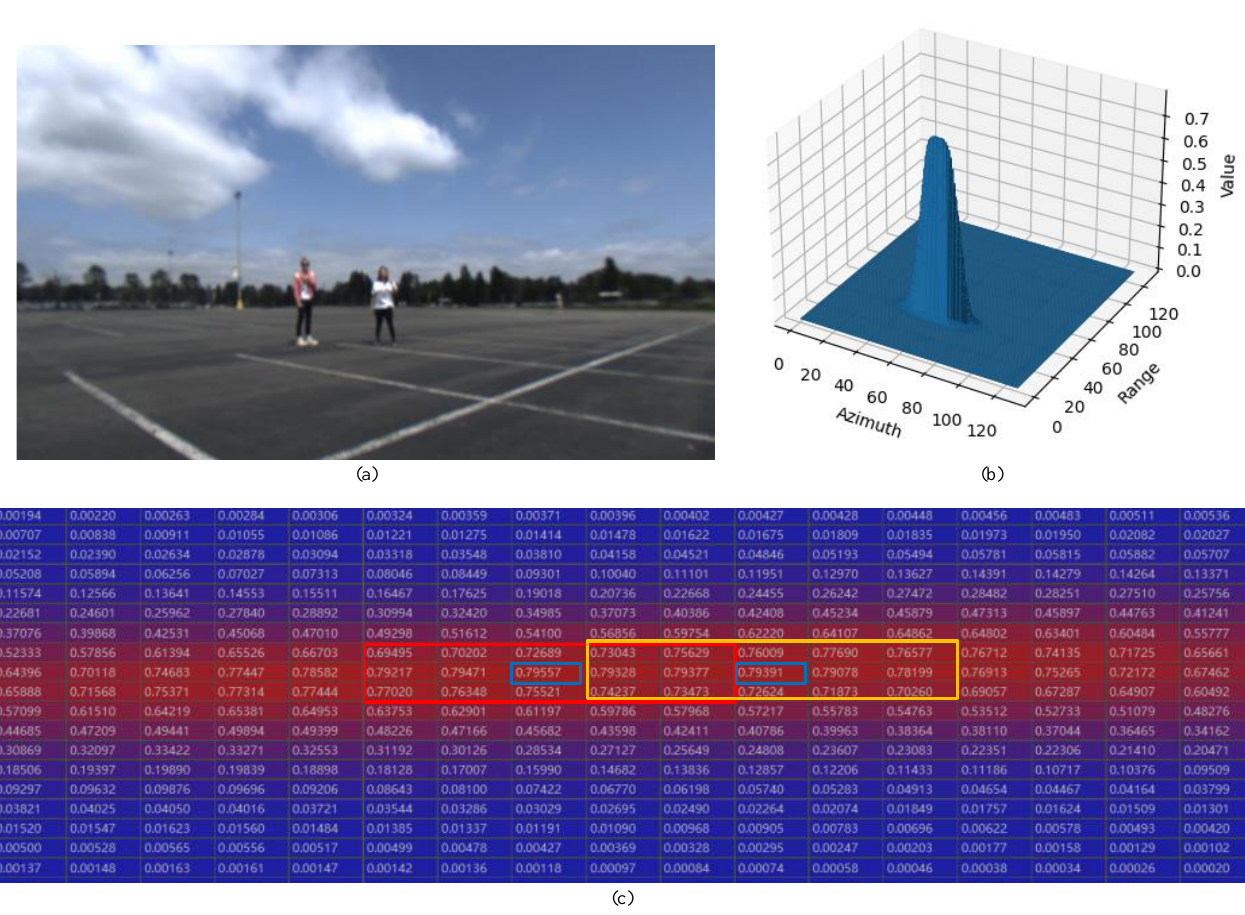
Figure 11. Case (4) data. ( a ) Optical photo of case (4). ( b ) A 2D ConfMap of case (4). ( c ) A 3D ConfMap of case (4). The red and yellow box in ( c ) represents a 3 × 5 slider, and the two blue box represents the primary screening peak. One of them will be suppressed.